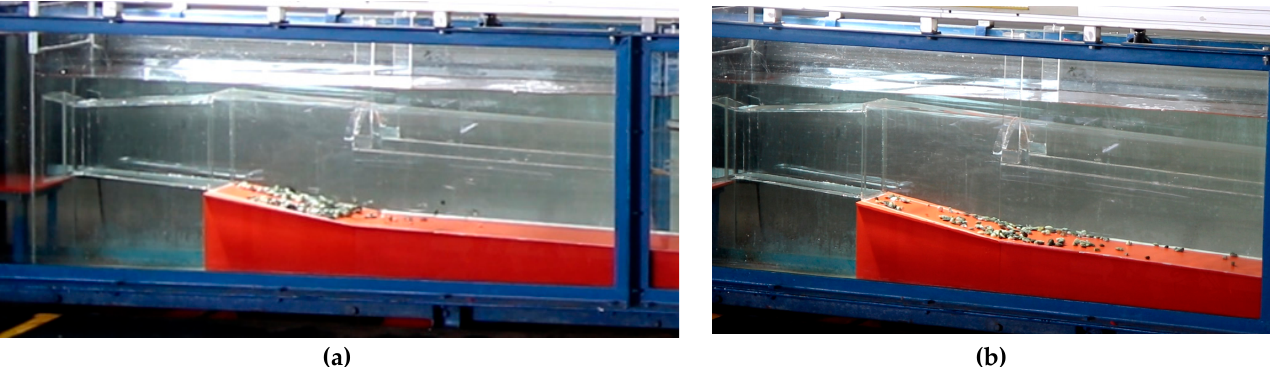
Figure 11. Gravel particles (diameter 5–30 mm) in the model test at the bottom of the diffusor; ( a ) early after input, and ( b ) after a retention time.